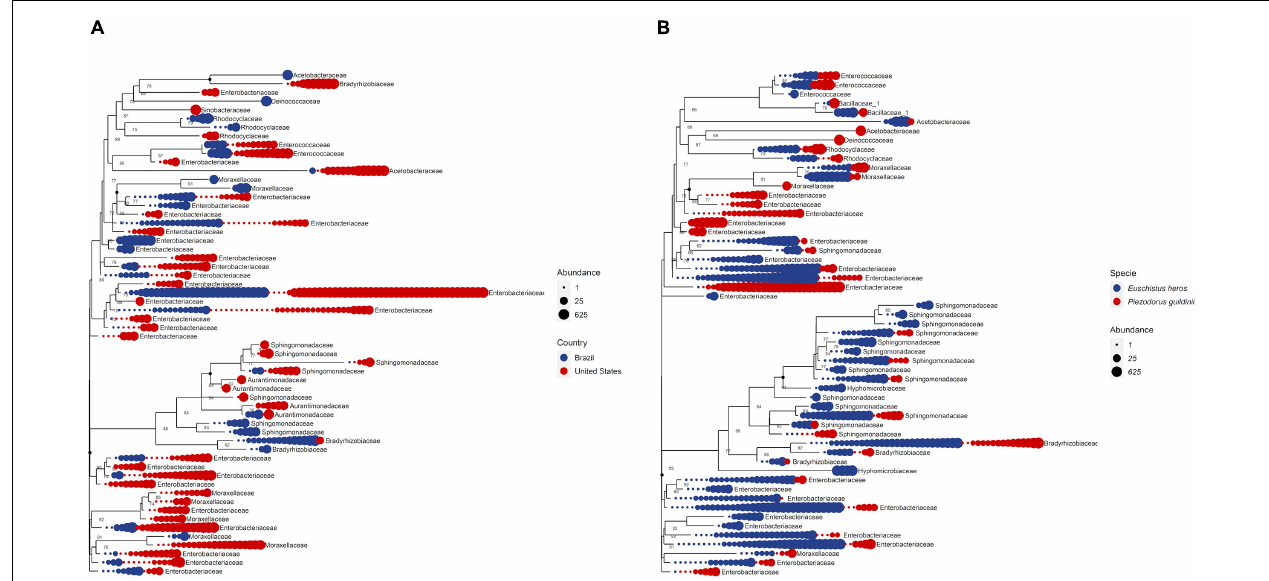
FIGURE 7 | (A) Phylogenetic tree comparing top 10 bacteria abundance at family level among countries. (B) Phylogenetic tree comparing top 10 bacteria abundance at family level among